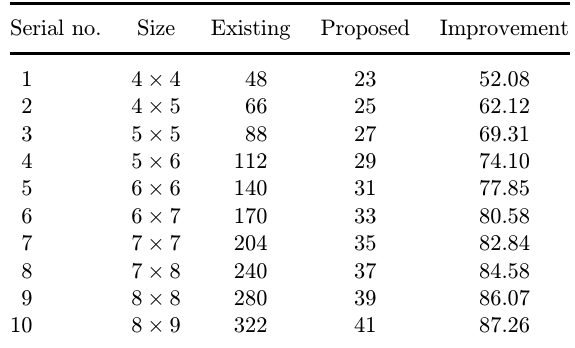
Table 2. Comparison with two existing techniques. Serial